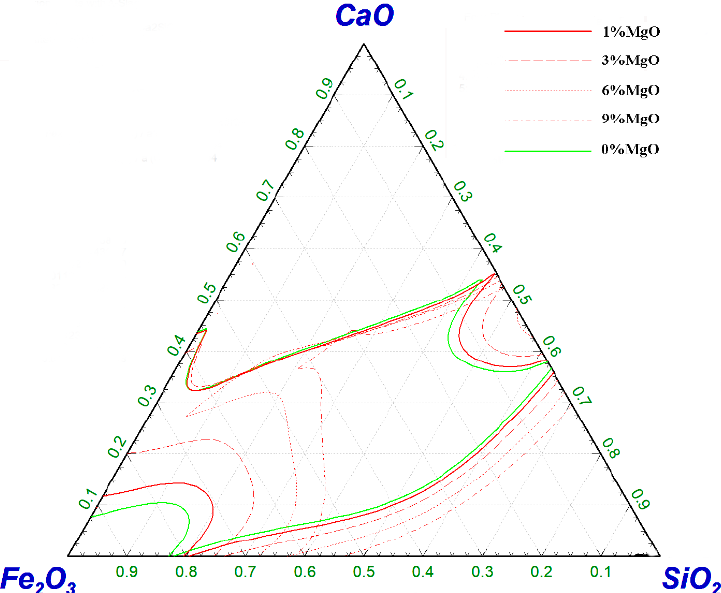
Figure 6. Effect of ω (MgO) on the liquid-phase region of CaO–SiO 2 –Fe 2 O 3 slag system at 1450 °C.